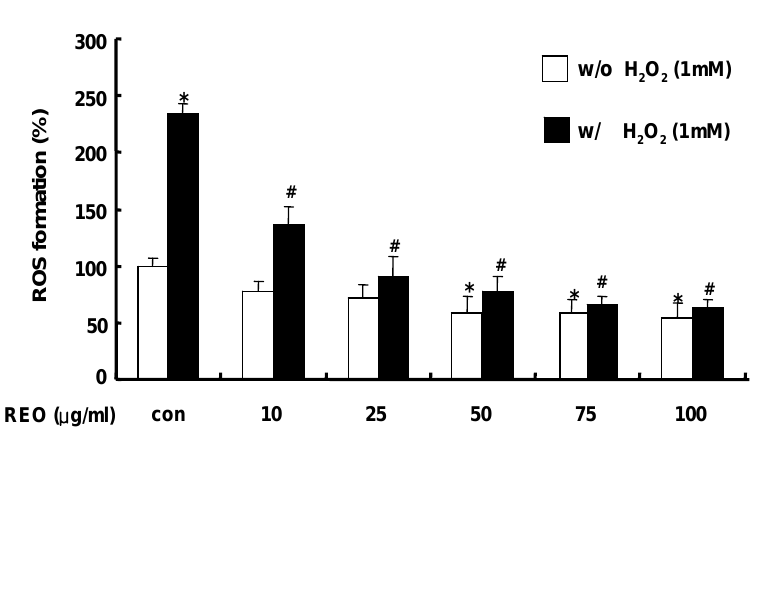
Figure 1. Effect of red ginseng essential oil (REO) on H species (ROS) formation in HepG2 cells pre-treated with 2’,7’-dichlorofluorescin diacetate (DCF-DA) for 1 h and exposed to REO for another 1 h with or without H means of three independent experiments ± S.D. ( n = 3). * p < 0.05, significantly different from the vehicle control in the absence of H vehicle control in the presence of H